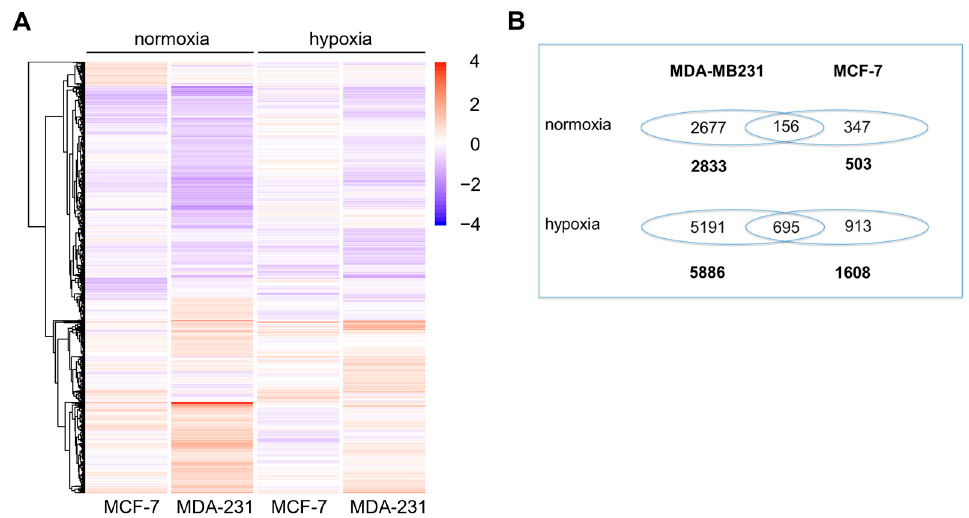
Figure 1. Heat map and Venn diagram of 10 μ M BA ‐ treated cells. Transcriptomic profiles of breast cancer cell lines under normoxia and hypoxia used cDNA microarray are presented. MDA ‐ MB ‐ 231 and MCF ‐ 7 cells were incubated with 10 μ M BA under normoxia (21 % O 2 ) and hypoxia (0.1 % O 2 ) for 48 h. ( A ) Heat map displays genes up ‐ regulated relative to DMSO treated control cells in red and down ‐ regulated genes in blue. ( B ) Differential gene expression was calculated as log2 ‐ fold ‐ change > 0.5 or < − 0.5 of DMSO control cells in at least three independent experiments ( p < 0.05). MCF ‐ 7 cells showed stronger response to hypoxic conditions than MDA ‐ MB ‐ 231